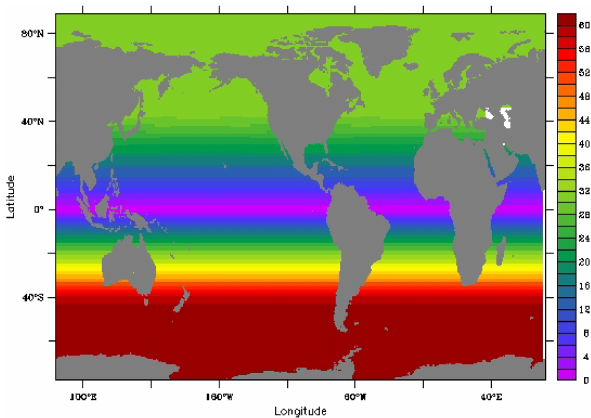
Figure 1. The mixing-length scale over which the ad hoc wind stir- ring parameterization is prescribed to act in the WSTIR simulation, in units of